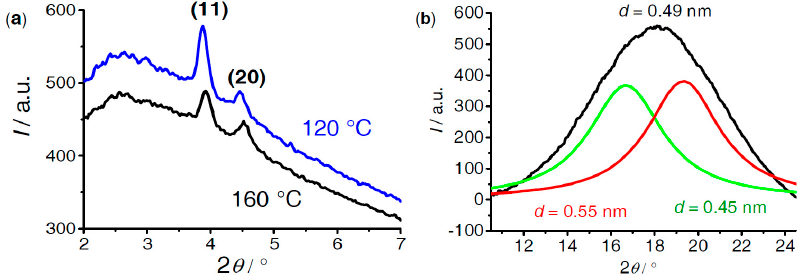
Figure 9. XRD patterns of compound E12/4F6 ; ( a ) SAXS patterns recorded at 120 and 160 °C, respectively; and ( b ) WAXS pattern at 120 °C, with fittings to two maxima representing the mean distances between the R F chains (0.55 nm) and the aliphatic molecular segments (0.45 nm).